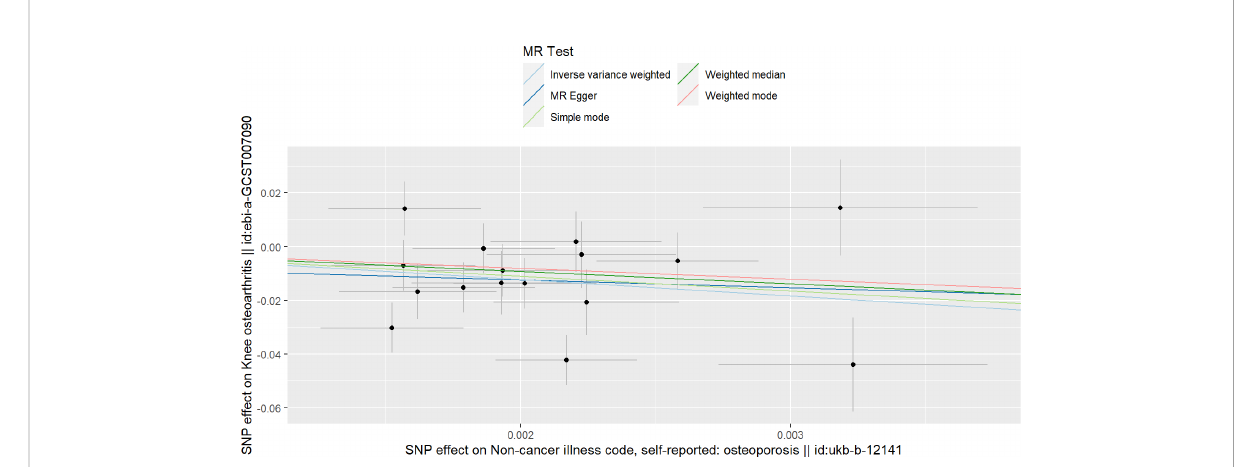
FIGURE 2 Scatterplots of the causal relationships between osteoporosis and knee osteoarthritis.